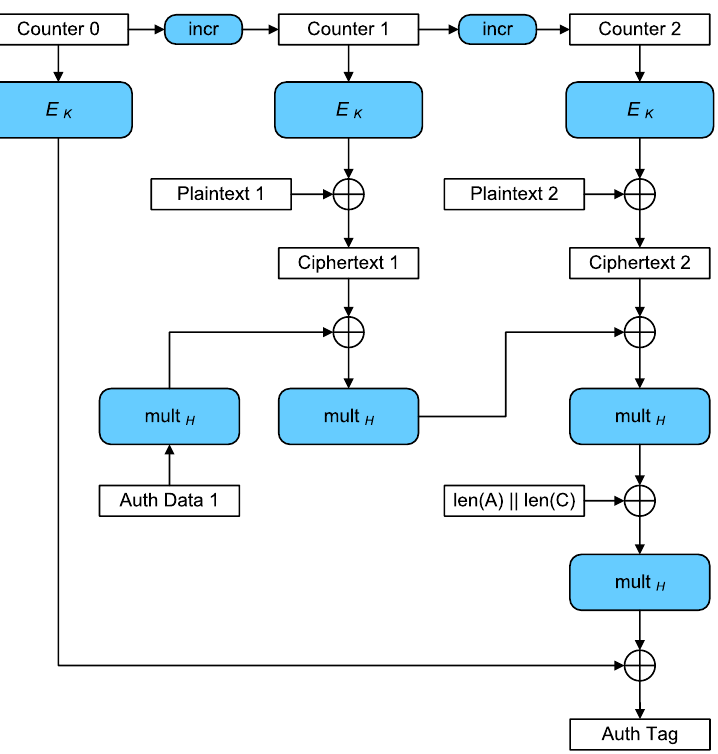
Figure 6. Galois Counter Mode encryption